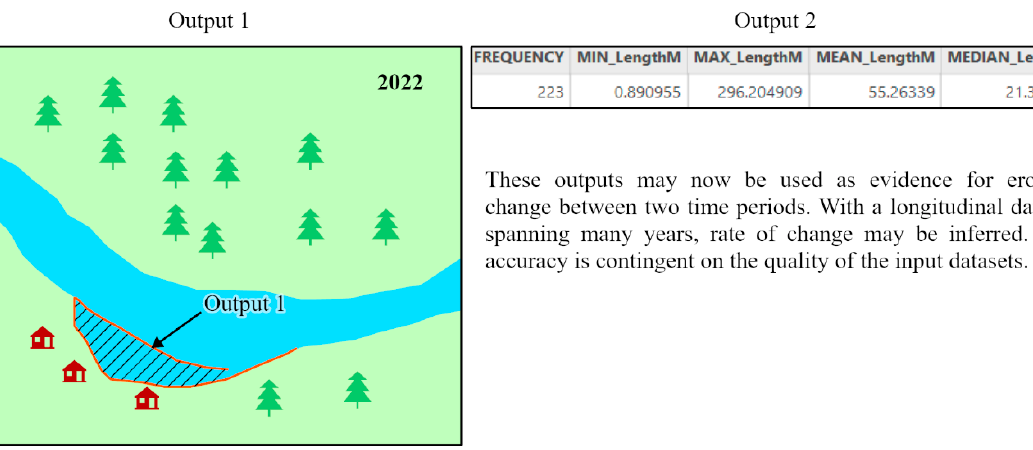
Figure 3. The open-access tool used in this study to measure erosion was developed by the authors for use in ESRI ArcGIS Pro, which every Alaska Native community has access to via the BIA.